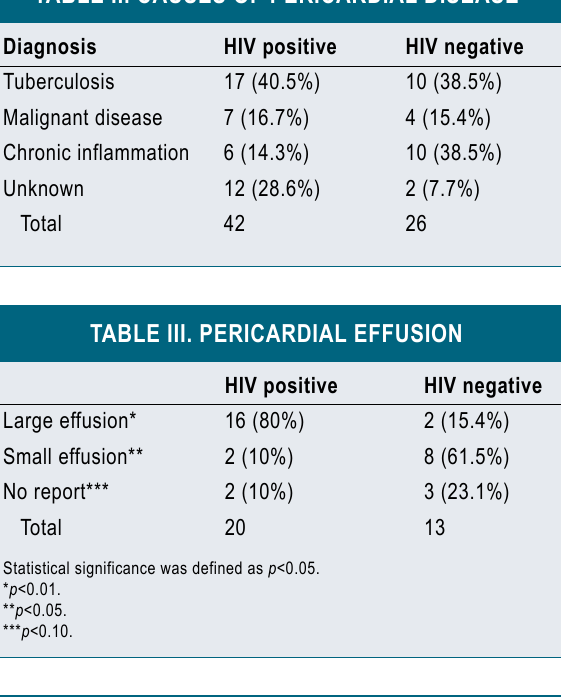
TABLE II. CAUSES OF PERICARDIAL DISEASE